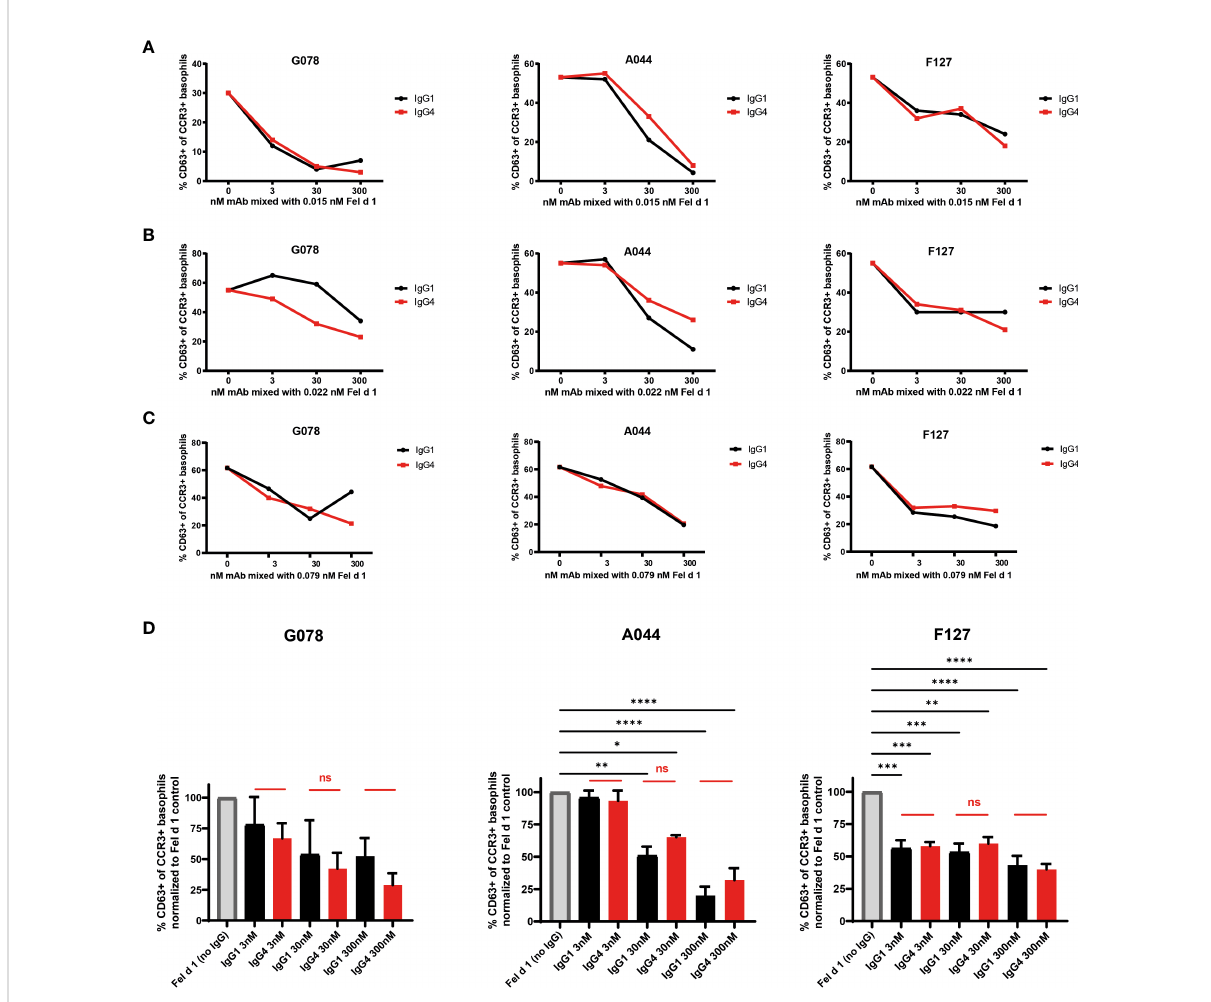
FIGURE 2 IgG1 and IgG4 mAbs equally well prevent basophil activation from cat allergic subjects. Blood from three (A – C) cat allergic subjects were collected and incubated with the donor speci fi c amount of recombinant Fel d 1 (subject A: 0.015 nM; subject B: 0.022 nM; subject A: 0.079 nM) as described in material and methods. That respective amount of Fel d 1 was also pre-mixed with 3, 30, and 300 nM of Fel d 1 speci fi c mAbs either in the format of IgG1 or IgG4. The percentage of CD63+ cells within the CCR3+ basophil population was measured. (D) Frequency of CD63+ cells within the CCR3+ basophil population of the three cat allergic subjects displayed in (A – C) normalized to frequency of CD63+ cells of the individual in the absence of IgG1/4 (maximal activation = 100%). Data are expressed as the mean of values ± SEM. For statistical analysis ordinary ANOVAs were performed. ns (not signi fi cant) for p > 0.05, * for p ≤ 0.05, ** for p ≤ 0.01, *** for p ≤ 0.001 and **** for p ≤